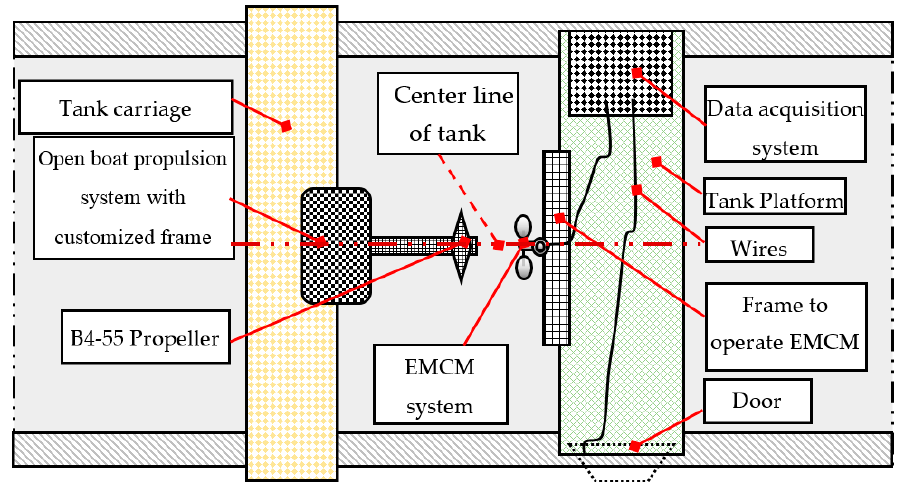
Figure 1. Schematic of experimental set-up.